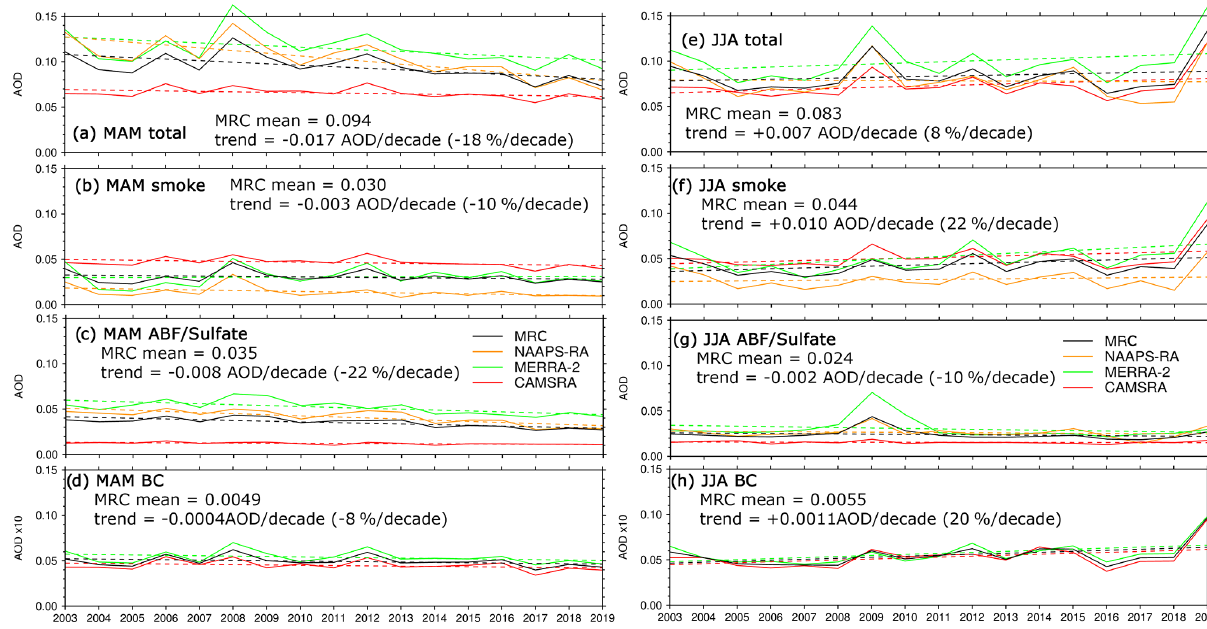
Figure 13. Time series of MAM and JJA 70–90 ◦ N area-mean total, BB smoke, ABF/sulfate, and BC AODs from the reanalyses and the MRC. Solid lines are AODs, and dashed lines are linear regressions indicating trends. For easier visualization, BC AOD is multiplied by 10.